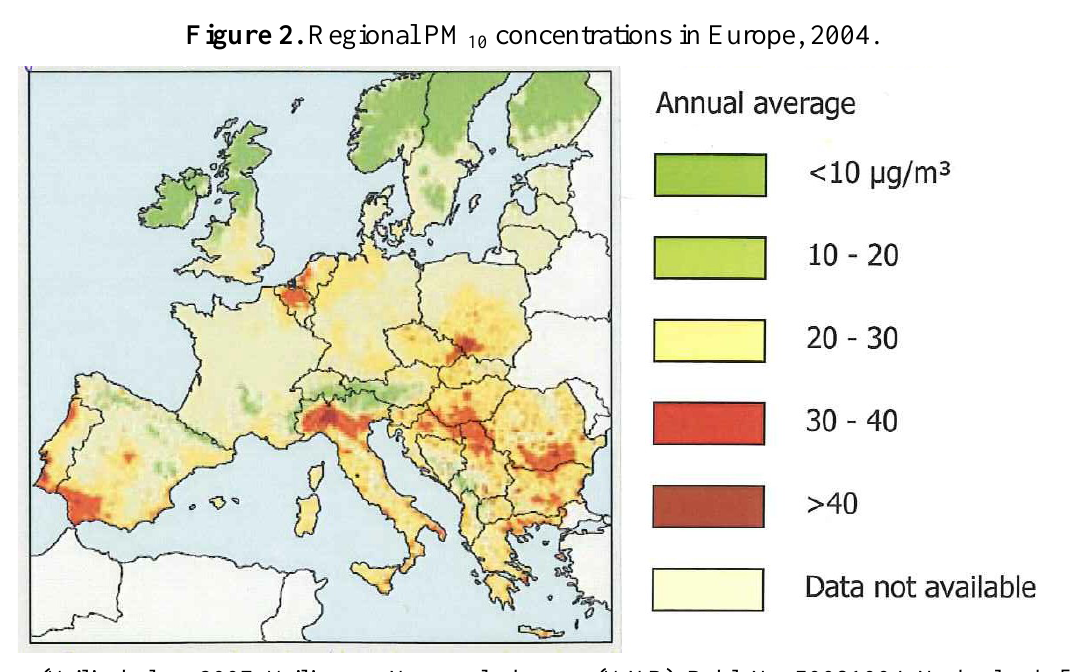
Figure 2. Regional PM